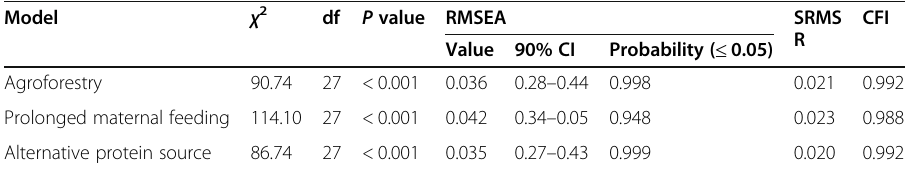
CFI R Value 90% CI Probability ( ≤ 0.05)